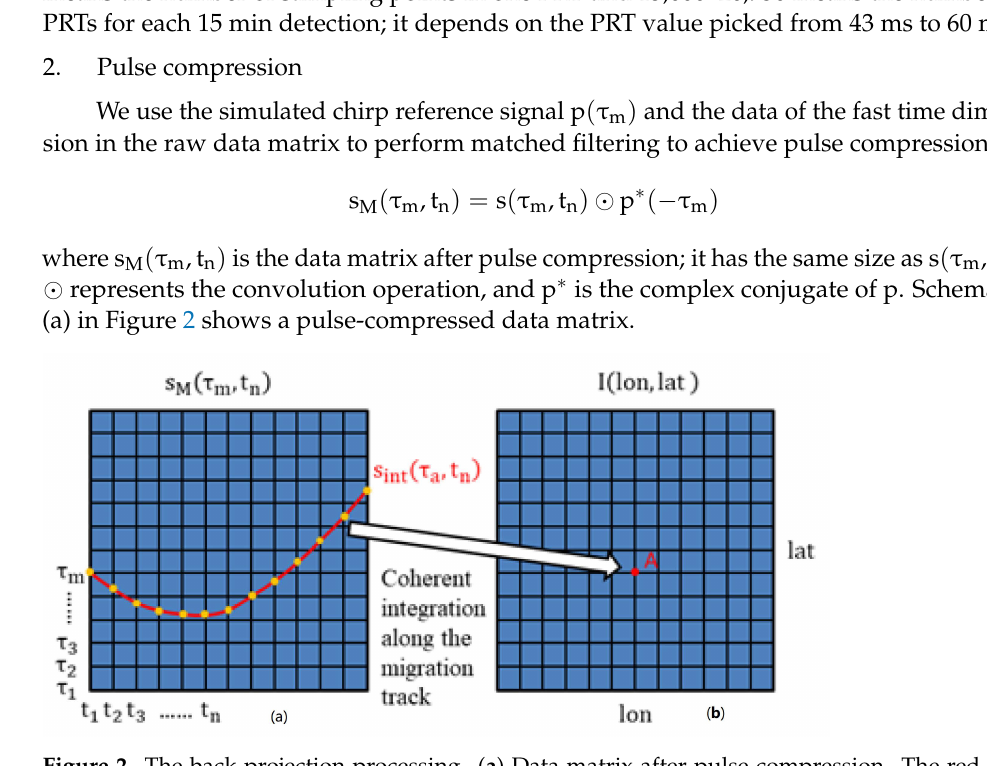
Figure 2. The back projection processing. ( a ) Data matrix after pulse compression. The red line represents the migration track of target imaging point A. The yellow dots represent the signal samples on the migration track of point A, which are obtained by interpolation. ( b ) Image obtained by back projection. The red dot denotes target imaging point